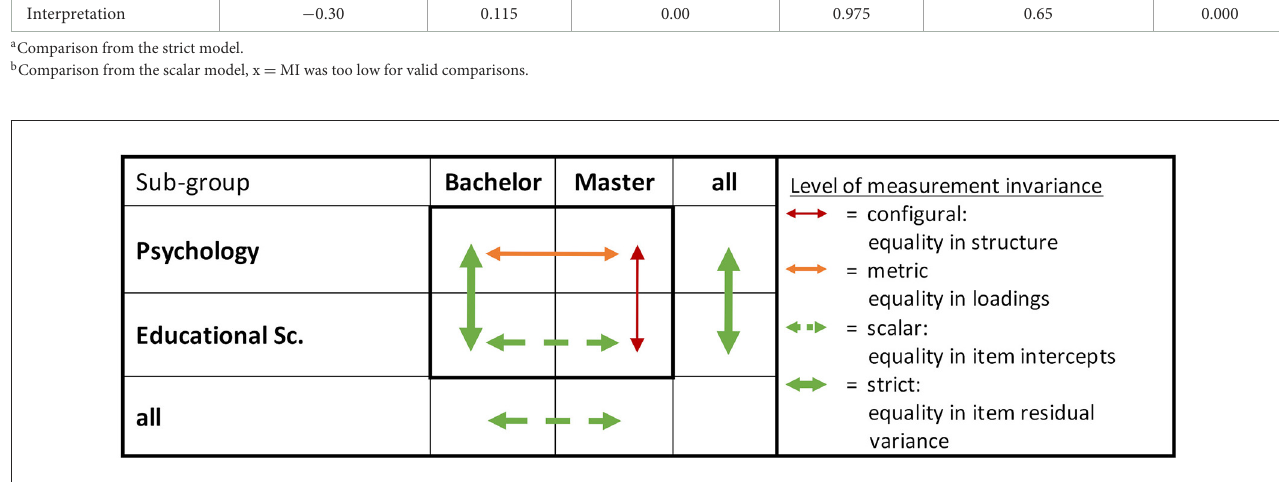
FIGURE2 Levels of measurement invariance between discipline and program level for total and sub-groups.